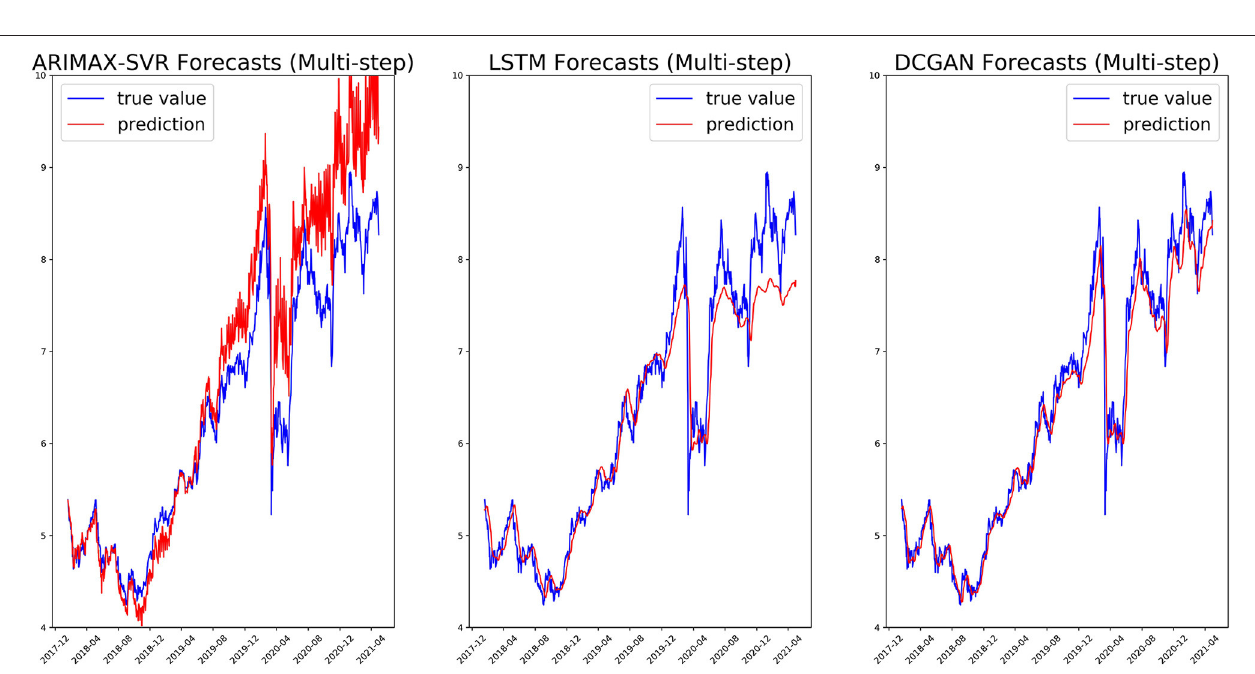
FIGURE 6 | Multi-step (5 days) forecasts on the ENEL test set for ARIMAX-SVR (left) , LSTM (center) , and our GAN architecture (right) .